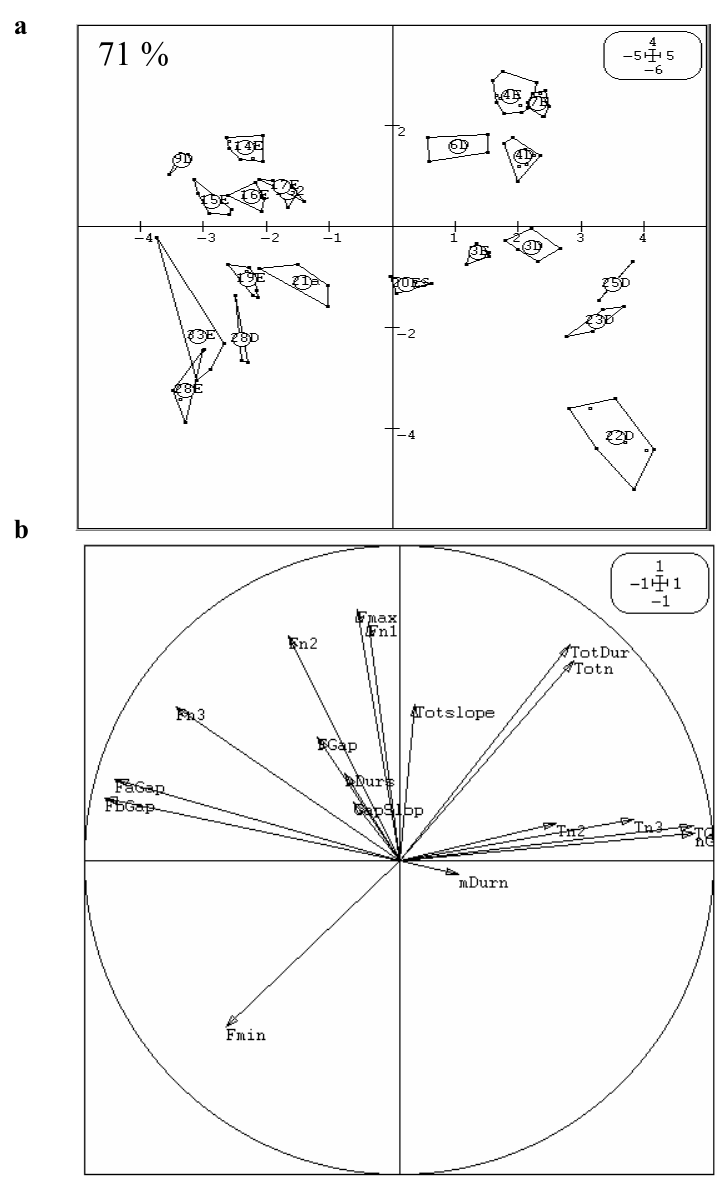
Fig. 3 – PCA analysis taking into account 2 factors (54% of the total variance) and based upon 18 acoustic parameters. On this basis, the PCA ( a ) separates 71% of the 21 individuals analyzed (each number corresponds to 1 individual). A correlation circle ( b ) identifies the parameters responsible for these